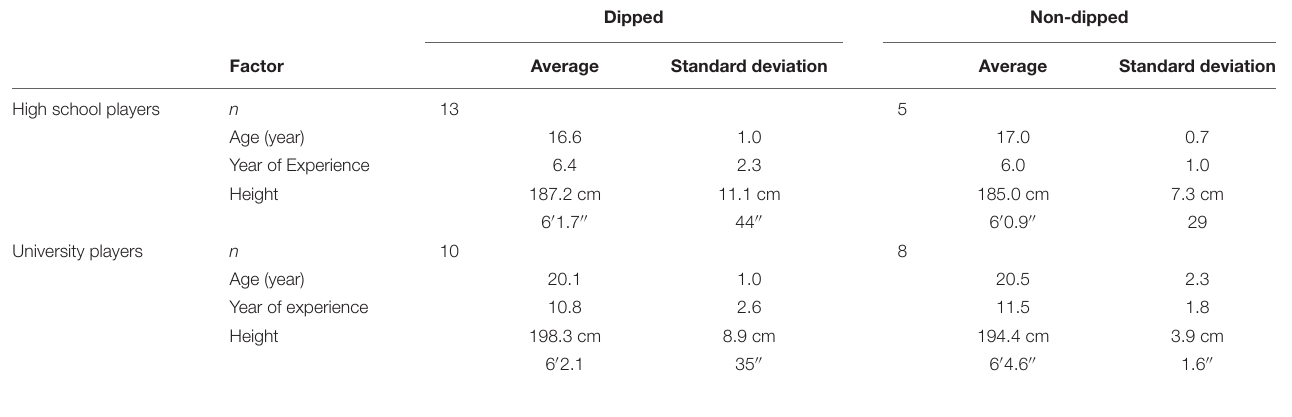
TABLE 2 | Demographics of the high school and university basketball